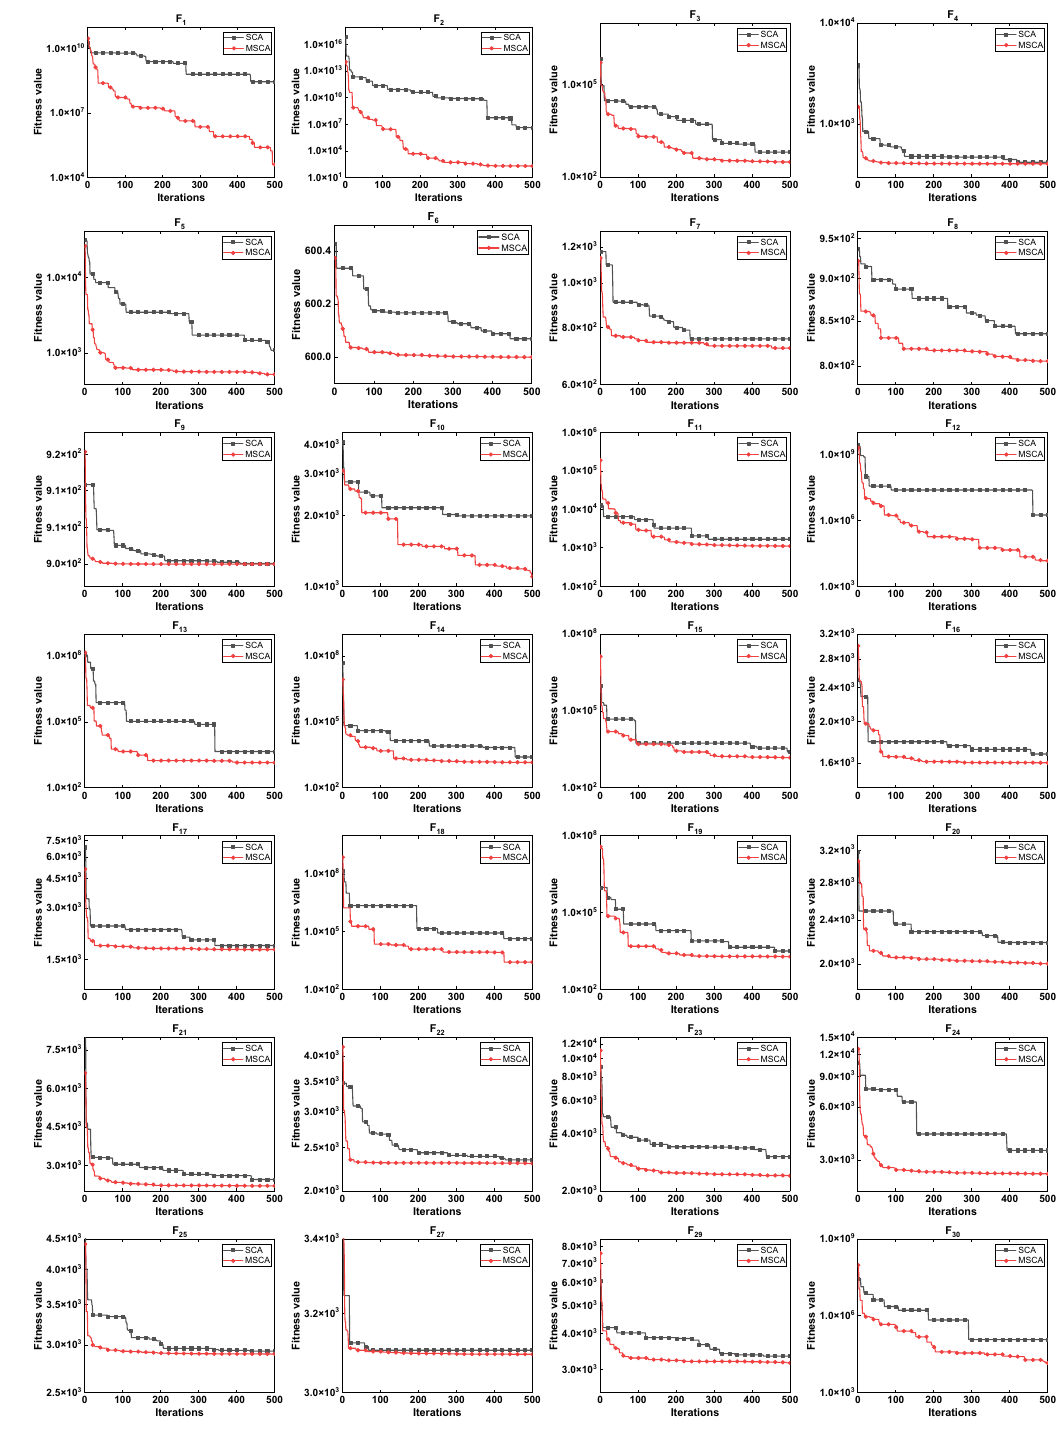
Figure 8. The convergence curve of SCA and MSCA on